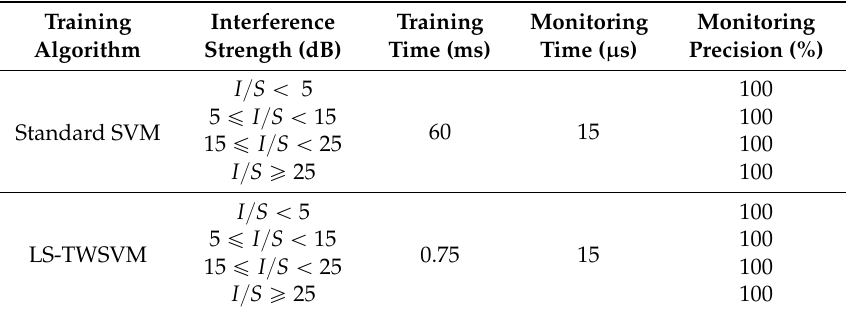
Table 1. Broadband interference monitoring result.